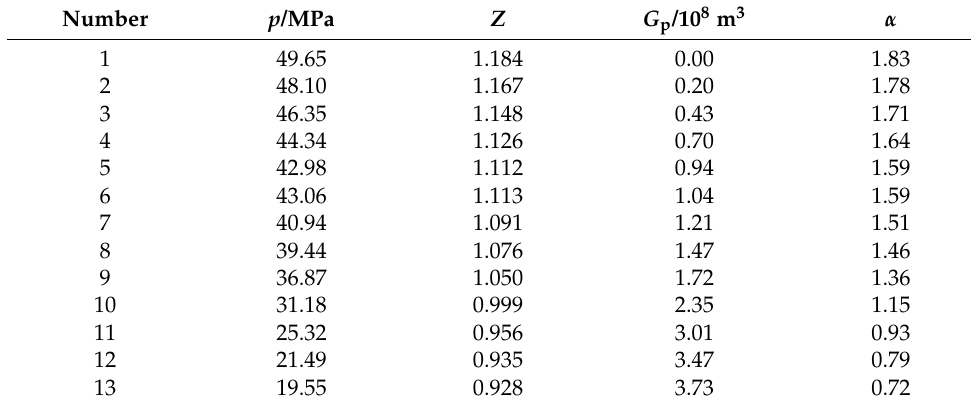
Table A3. Historical production data of the Stafford reservoir [20].